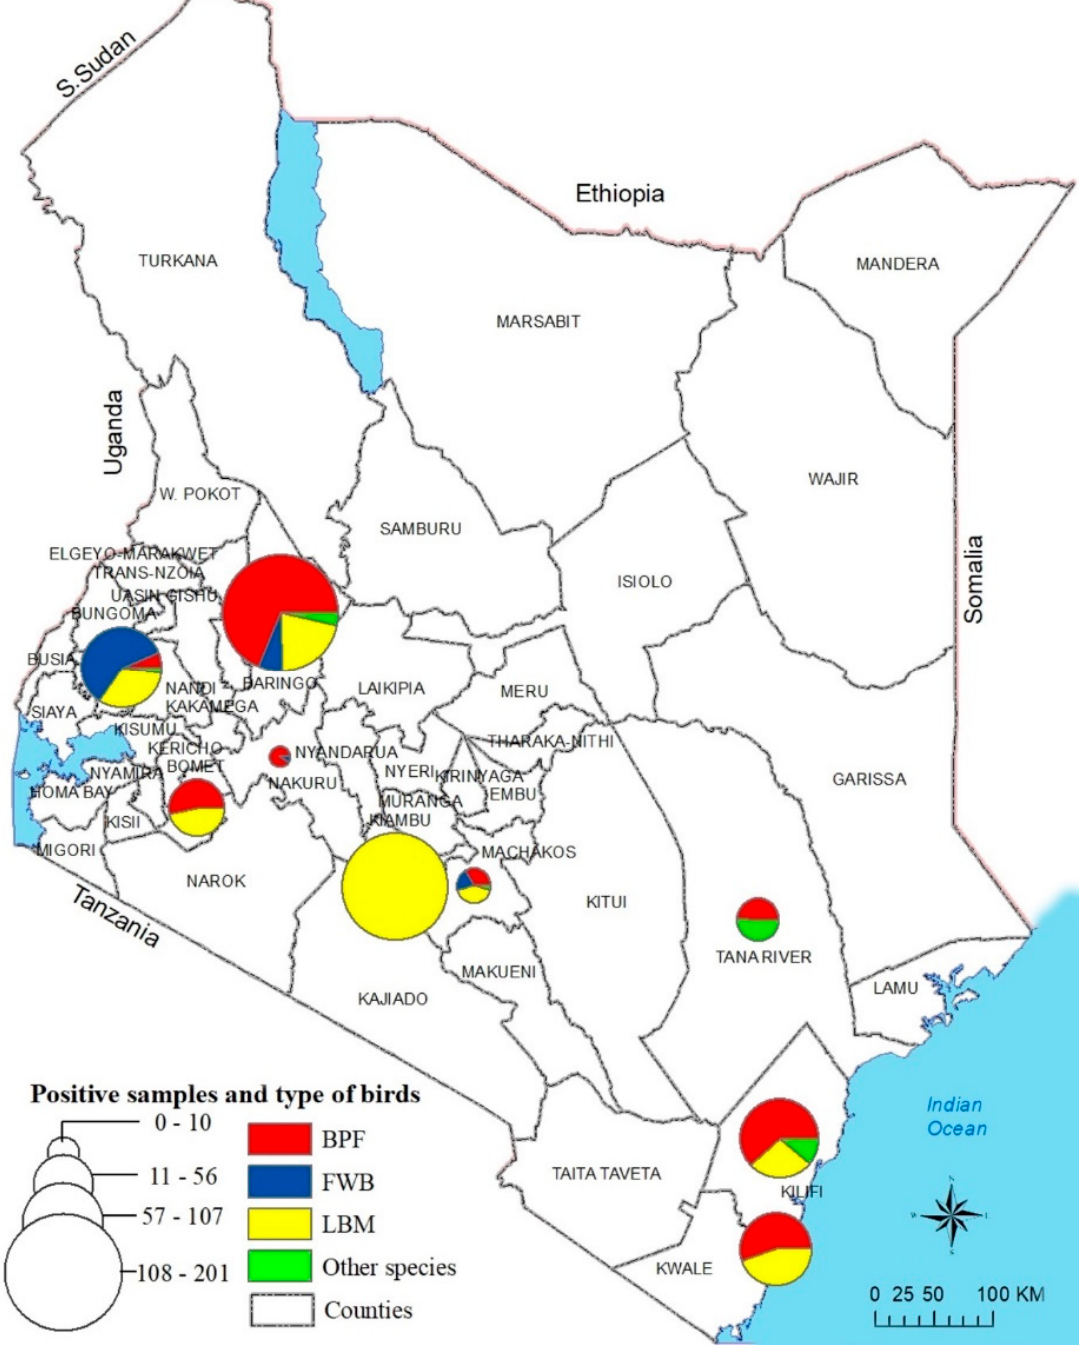
Figure 1. Sampling sites in nine counties of Kenya from where the NDV-positive samples originated. The sampling sites were mapped using GPS coordinates recorded during the sampling. A total of 641 birds swabbed from 66 BPFs and 21 LBMs from nine counties in Kenya tested positive for NDV by rRT-PCR using the L-tests described in the text. Circle sizes correspond to the numbers of virus-positive samples. Abbreviations: BPF, backyard poultry farm; WFB, wild fam birds.